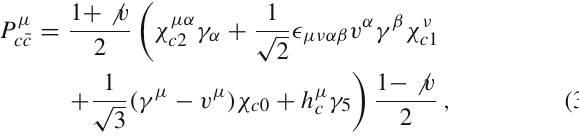
Fig. 1 The hadron-level diagrams for charmless decay modes χ (cid:2) V V via intermediate charmed meson loops